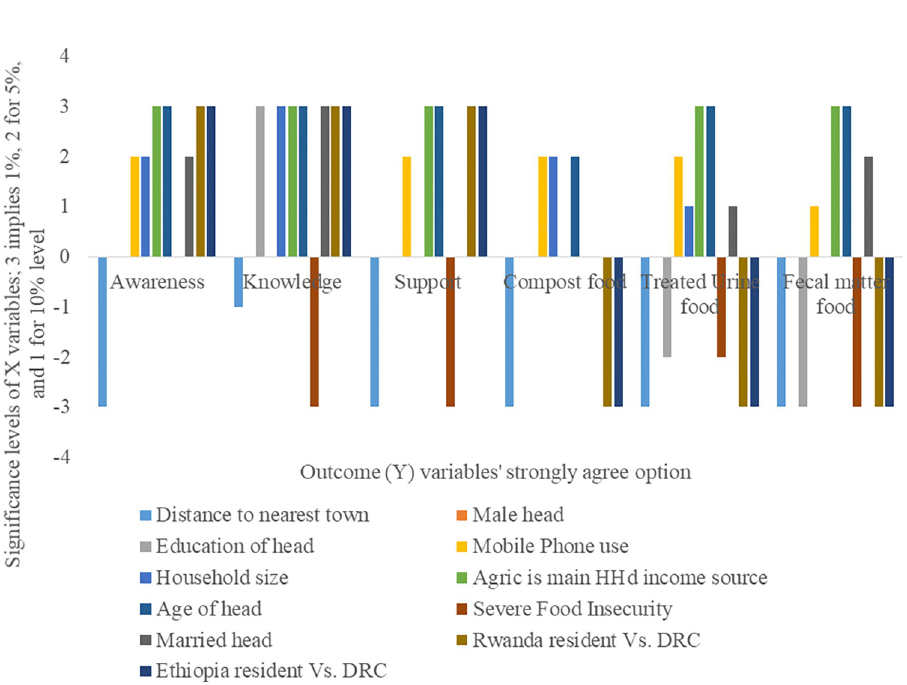
Fig 3. Significant results for the strongly agree option across all outcome